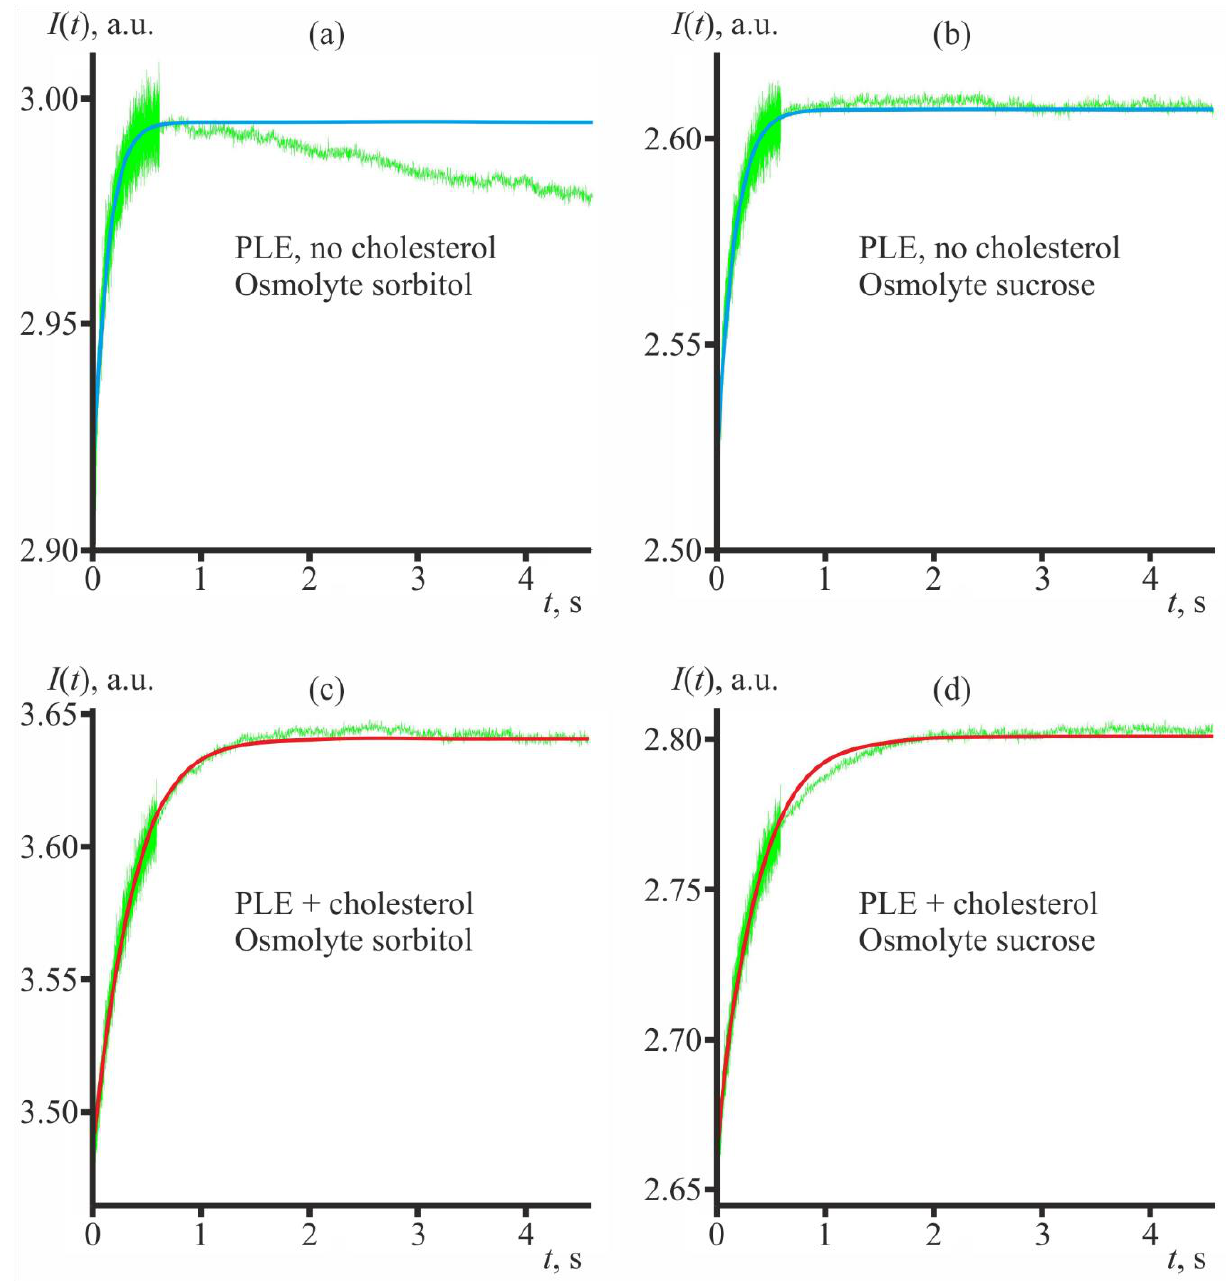
Figure 2. Representative dependences I ( t ) of the light intensity scattered from LUV suspensions after application of the hyperosmotic gradient. ( a , b ) — LUVs made from PLE (no cholesterol) with sorbitol ( a ) or sucrose ( b ) used as an osmolyte. ( c , d ) — LUVs made from PLE + cholesterol lipid mixture with sorbitol ( c ) or sucrose ( d ) used as an osmolyte. Solid blue and red curves represent the fit of the experimentally determined dependence I ( t ) (green traces) by Equation (3). The membrane permeability with respect to water determined from the fits is P f = 5.7 µm/s (PLE + cholesterol membrane) and P f = 12.7 µm/s (PLE membrane) both for sucrose and sorbitol used as an osmolyte. All curves are rather well fitted by a single-component Lambert function.